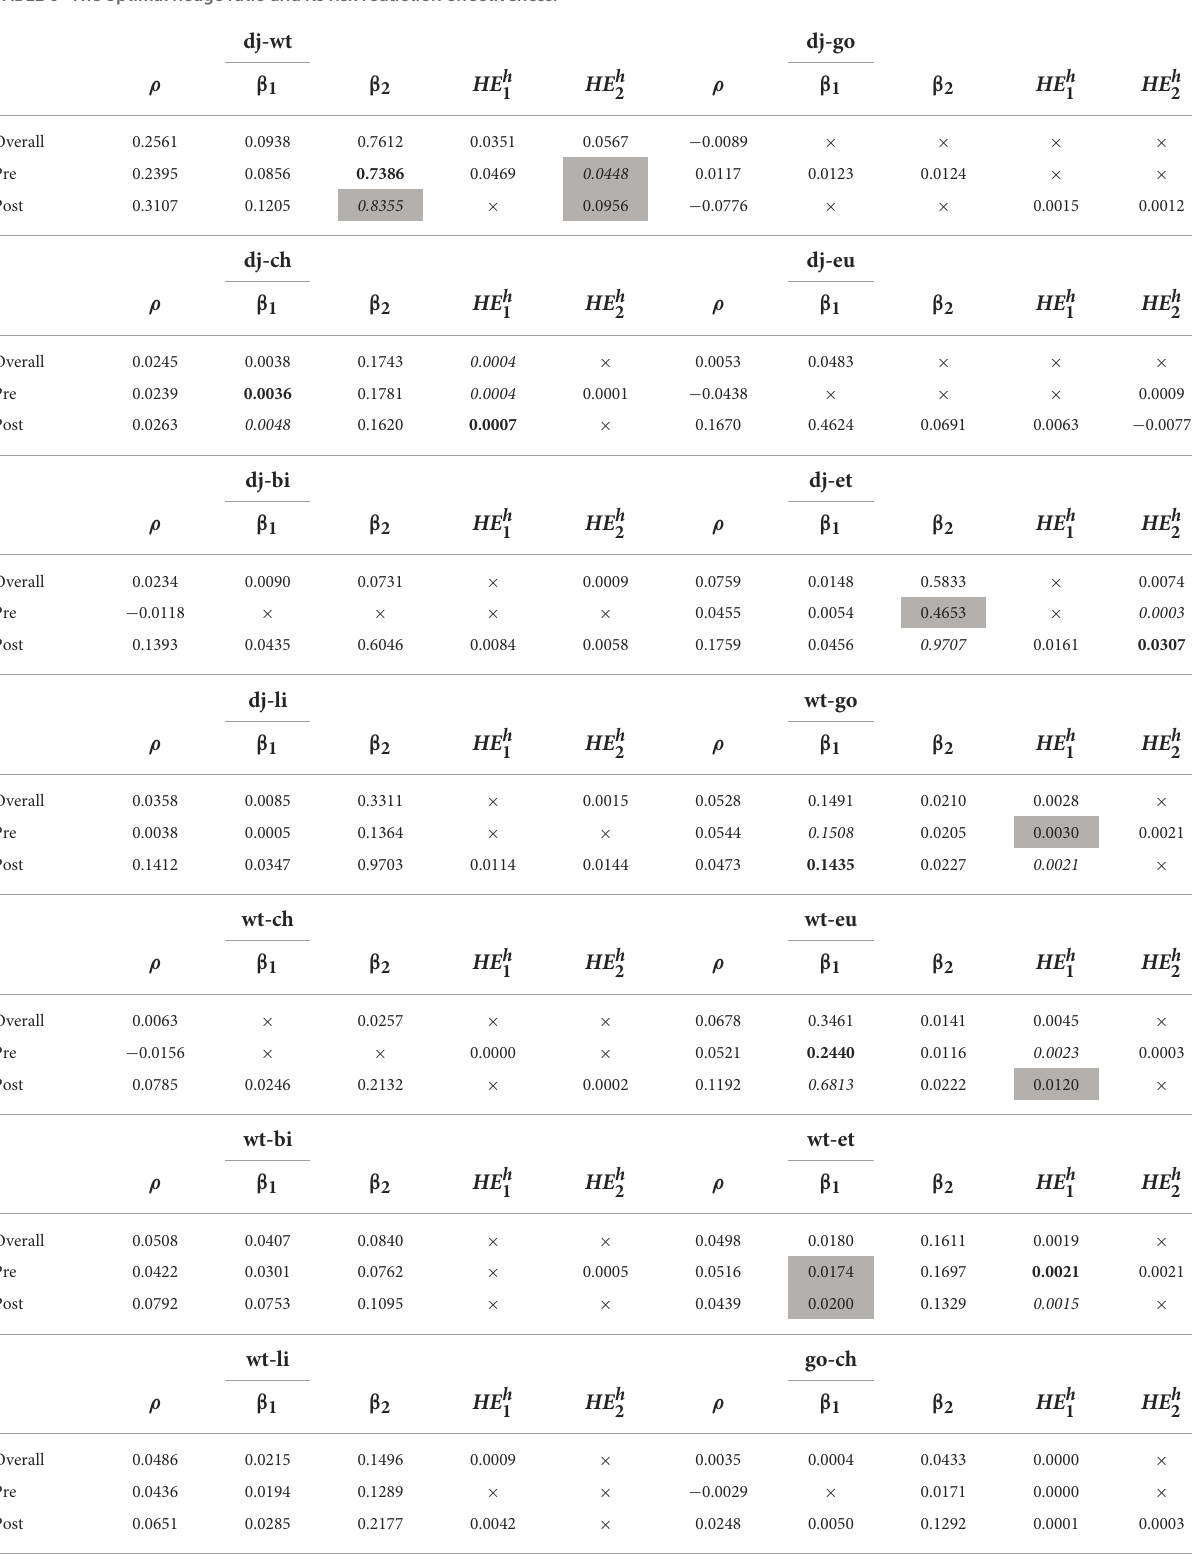
TABLE 6 The optimal hedge ratio and its risk reduction